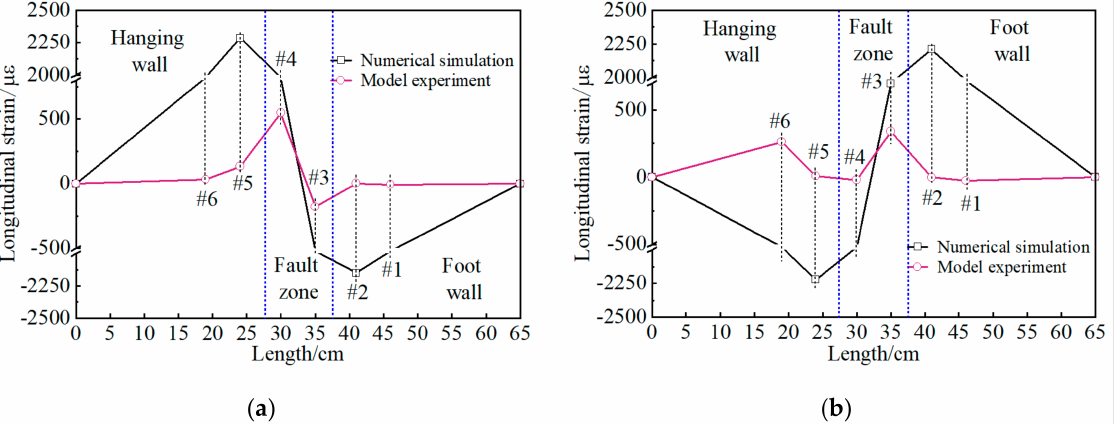
Figure 16. Longitudinally strained side walls of the tunnel in the numerical and model experiments. ( a ) left wall; ( b ) right